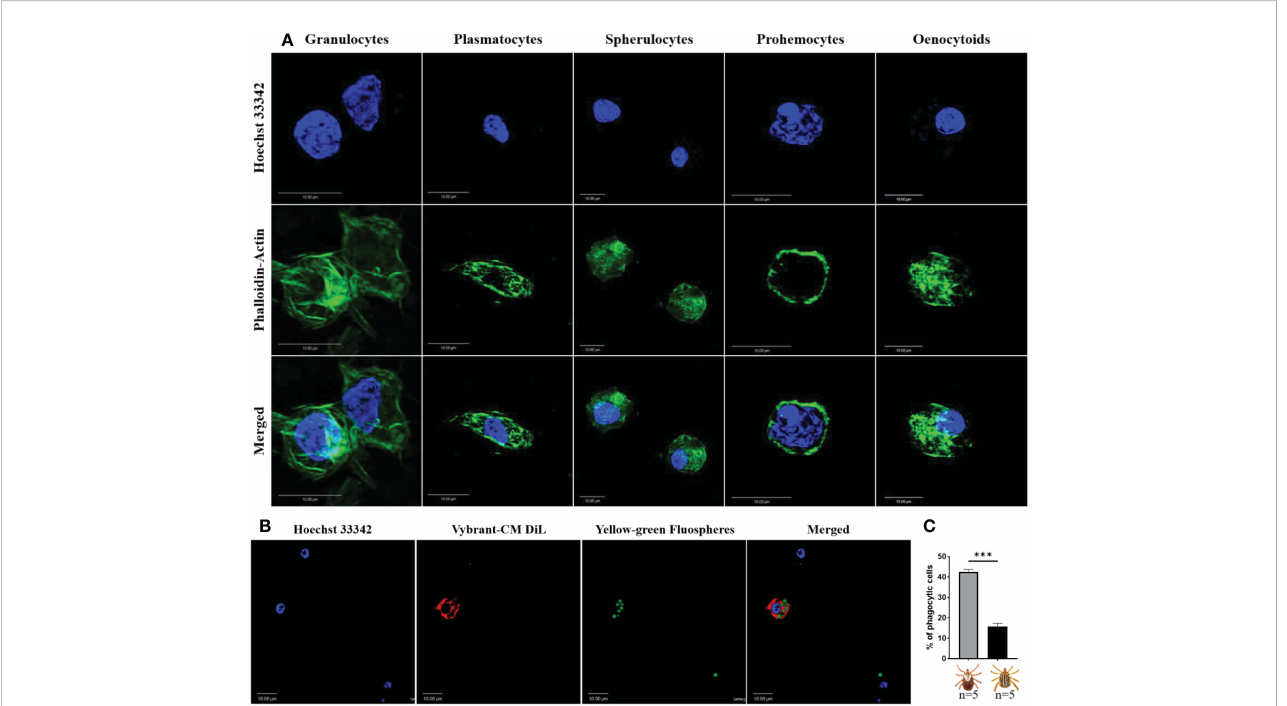
FIGURE 1 Confocal microscopy images of Am. maculatum hemocytes stained with phalloidin (green) and Hoechst 33342 (blue). Hemocytes were subtyped based on nuclear size and location and cytoplasmic projections (A) . Granulocytes are relatively large and have multiple actin projections. Plasmatocytes are pyriform and have a centrally placed nucleus. Spherulocytes possess a peripherally placed nucleus. Prohemocytes are characterized by a relatively large nuclear to cytoplasmic ratio and oenocytoids by a smaller nuclear to cytoplasmic ratio. Hemocytes were incubated with Hoechst 33342 (blue) and Alexa Fluor ™ 488 Phalloidin (green) that labels the nucleus and actin respectively. Representation of a phagocytic hemocyte following injection of green FluoSpheres and subsequent staining of the nucleus with Hoechst 33342 (blue) and membrane with Vybrant-CM Dil (Red) (B) and the quanti fi cation of phagocytic hemocytes in male and female ticks (C) . Quantitative data were analyzed using unpaired t- tests in GraphPad Prism v8.4.1. ***P < 0.001. Scale bar = 10 m